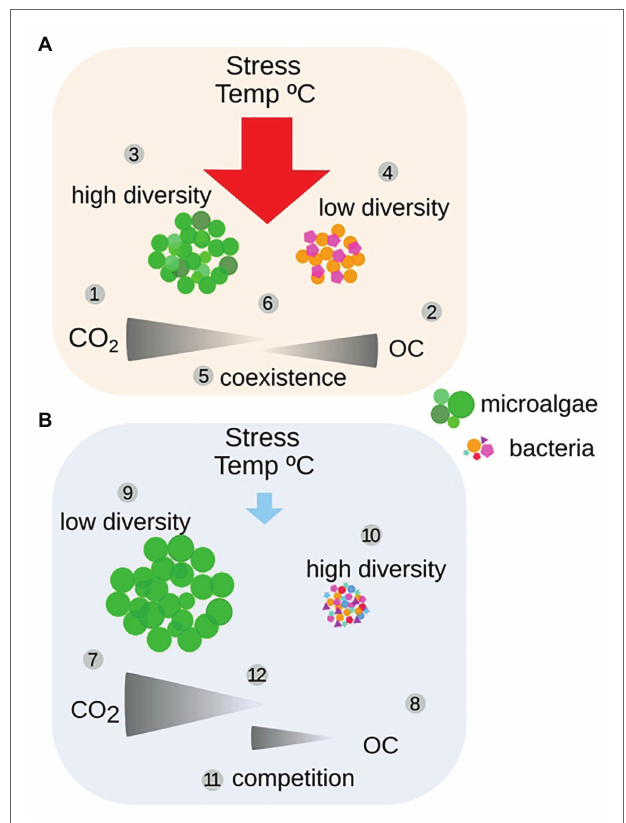
FIGURE 9 | Conceptual model of the impact in microalgae-bacteria interactions induced by temperature stress (A) . Less CO 2 got incorporated (1) while microalgal excretion of organic C (OC) was utilized by bacteria (2), leading to a higher diversity of the microalgae (3) and a lower diversity of the bacterial community (4). Resulting in coexistence (5), due to the partitioning of carbon resources (6). The release from temperature stress (B) introduced more CO 2 to the system resulting in a higher accumulation of microalgal biomass (7), while less OC got excreted (8), leading to a lower diversity of the microalgae, being dominated by one species (9), while the bacterial diversity became higher (10). This resulted in competition between microalgae and bacteria for organic carbon (11), due to mixotrophic microalgal uptake of both CO 2 and OC (12). The partitioning of carbon resources is indicated by CO 2 (flue gas) and OC (autochthonously produced carbon; see Discussion for